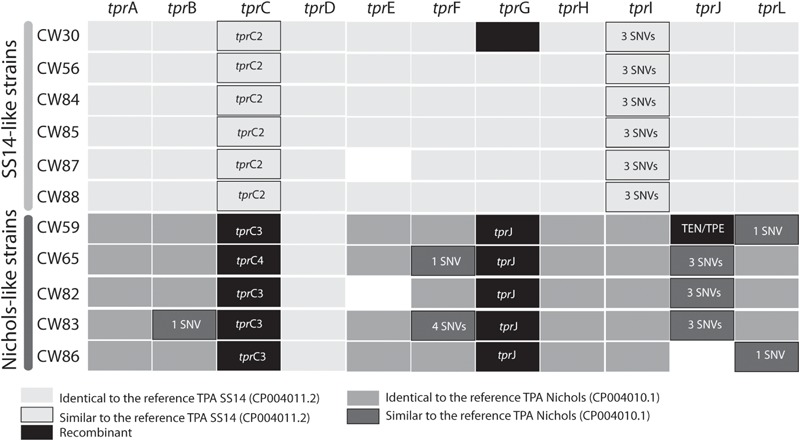
Allele variants of tpr genes found among examined clinical samples. To overcome the paralogous character of tpr genes, these loci were PCR amplified using primers with unique binding sites upstream and downstream the genes. The details are given in the section “Materials and Methods”. The allele variants are presented as a different color code (see legend under the figure). The blank spaces (e.g., tprE in CW87 and CW82; tprJ in CW86) represent genome regions which were not amplifiable in the given samples. TprK variants are missing due to their hyper-variable sequences based on different subpopulations of the same strain. The tprC allelic variants are shown in Supplementary Figure S2.